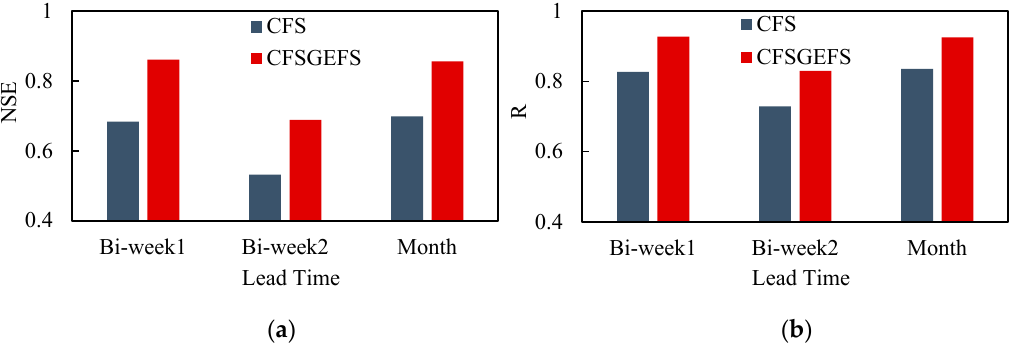
Figure 14. The evaluation results of integrated forecast precipitation in weekly and monthly lead time: ( a ) the result of NSE; and ( b ) the result of